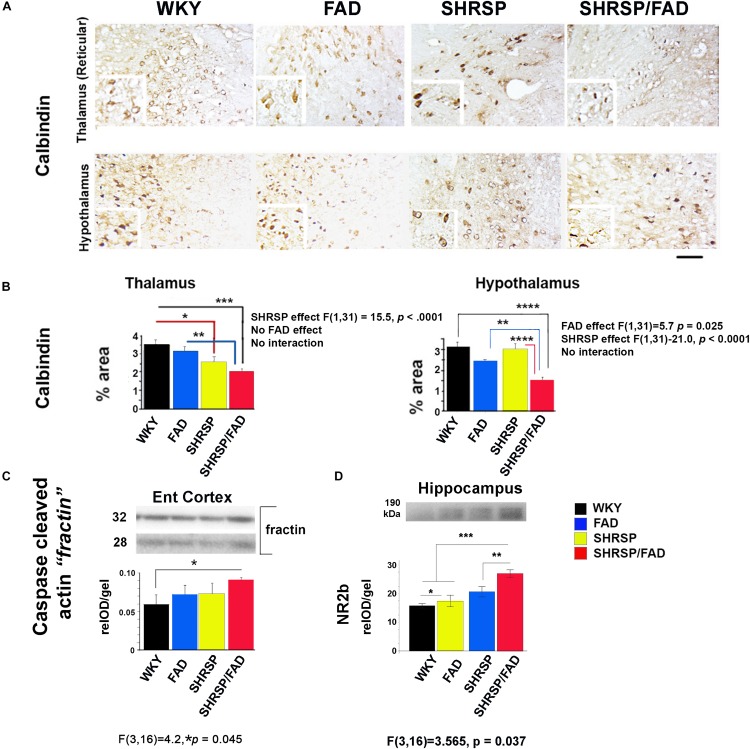
Neuron-specific calbindin is reduced in SHRSP/FAD rats, while caspase-cleaved actin is increased. (A) Micrographs depict calbindin staining in the hypothalamus and thalamus showing numerous calbindin-immunoreactive neurons. (B) Two-way ANOVA of percentage area stained (SHRSP × FAD) in the reticular thalamus showed no effect of sex, but a significant main effect of SHRSP (p < 0.0001), consistent with post hoc analysis, which showed that calbindin staining was reduced in SHRSP (p < 0.05) and SHRSP/FAD (p < 0.001) rats, compared to WKY. Furthermore, calbindin staining was significantly reduced in SHRSP/FAD rats, compared to FAD (p < 0.01), suggesting that FAD exacerbates neuron loss in SHRSP rats. Changes in calbindin staining in the hypothalamus were similar, and while there was a main SHRSP effect (p < 0.0001), there was an additional FAD main effect (p < 0.025). Post hoc analysis showed that calbindin staining was significantly reduced in the hypothalamus of SHRSP/FAD rats, compared to SHRSP (p < 0.0001), FAD (p < 0.01), and WKY (p < 0.0001) rats. (C) We also measured caspase-cleaved actin in the entorhinal cortex as an indication of caspase activity by western blot (lower panel). One-way ANOVA of relative optical density showed a significant strain effect (p = 0.045), and post hoc analysis showed that levels of caspase-cleaved actin were increased in SHRSP/FAD rats compared to WKY rats (p < 0.05). (D) Levels of post-synaptic NR2B were significantly different among strains. There were main effects of strain, and post hoc analysis showed a slight elevation of NR2B levels in FAD compared to WKY, but levels in SHRSP/FAD groups were higher than all other groups (p < 0.01). Data represent means ± SEM. ∗p < 0.05, ∗∗p < 0.01, ∗∗∗p < 0.001, ****p < 0.0001; one- and two-way ANOVA with LSD Fisher’s post hoc test.